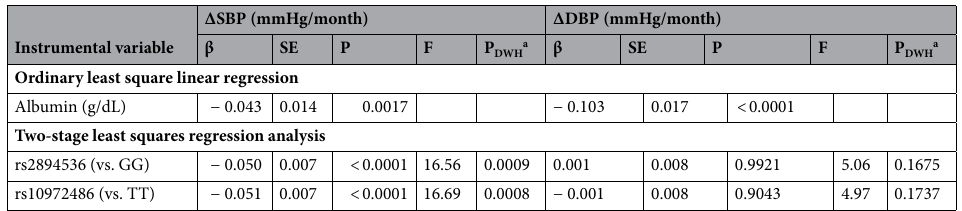
Table 3. Relationship of serum albumin (endogenous variable) with the change in (A) systolic blood pressure (ΔSBP) and diastolic blood pressure (ΔDBP) as tested both by ordinary least squares linear regression and the application of two-stage least squares regression analysis using candidate genetic polymorphisms as an instrument variable. Regression results were adjusted for age and sex. SE, standard error. a Estimated using the Durbin-Wu-Hausman test, which examines the difference between the estimates from ordinary least squares linear regression and instrumental variable analysis.